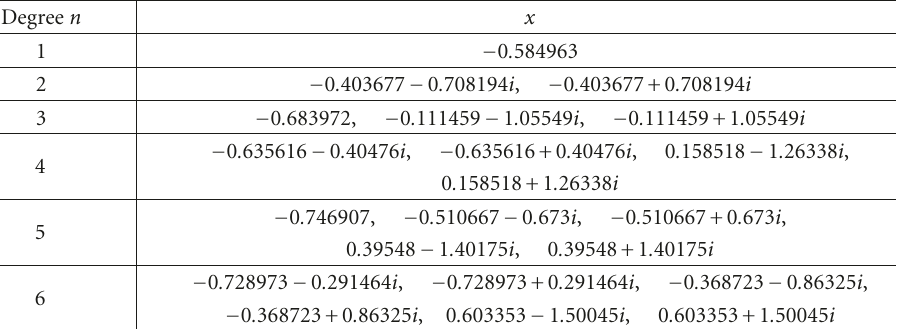
Table 4 . 2 . Approximate solutions of E n , q , w ( x ) = 0, w = e 2 πi/ 2